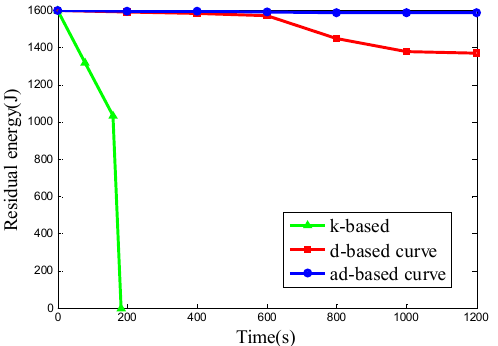
Figure 21. The residual energy of the network in node deployment (a): C 1 , C 2 , C 4 are deployed with 50 nodes and C 3 is deployed with 650 nodes.